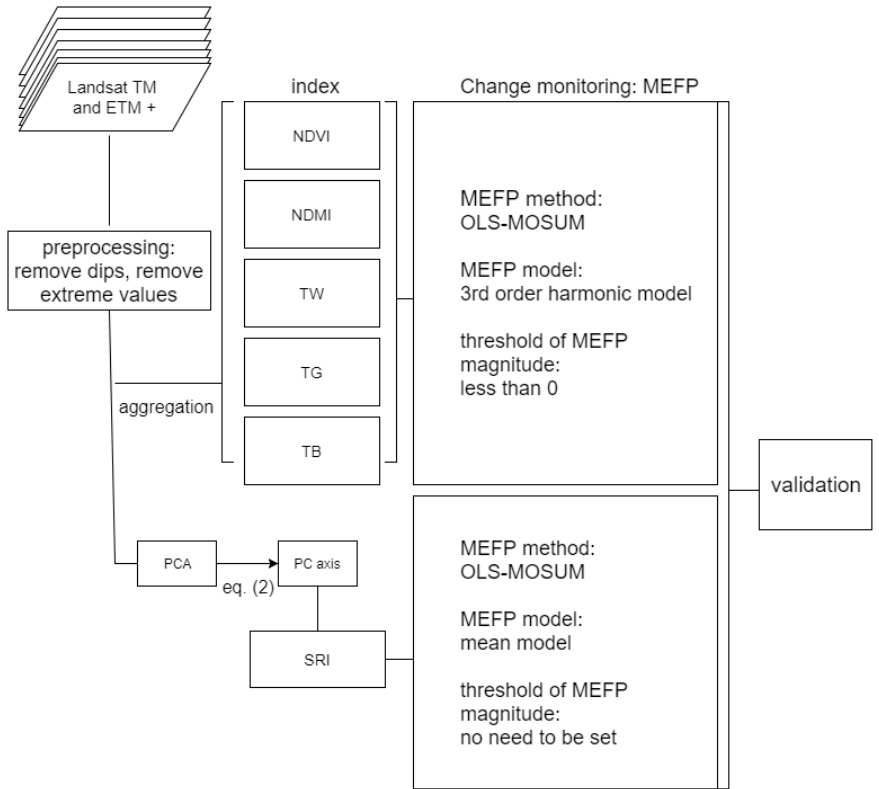
Figure 4. Flowchart of our experiment comparing SRI and conventional vegetation indices. MOSUM, Moving Cumulative